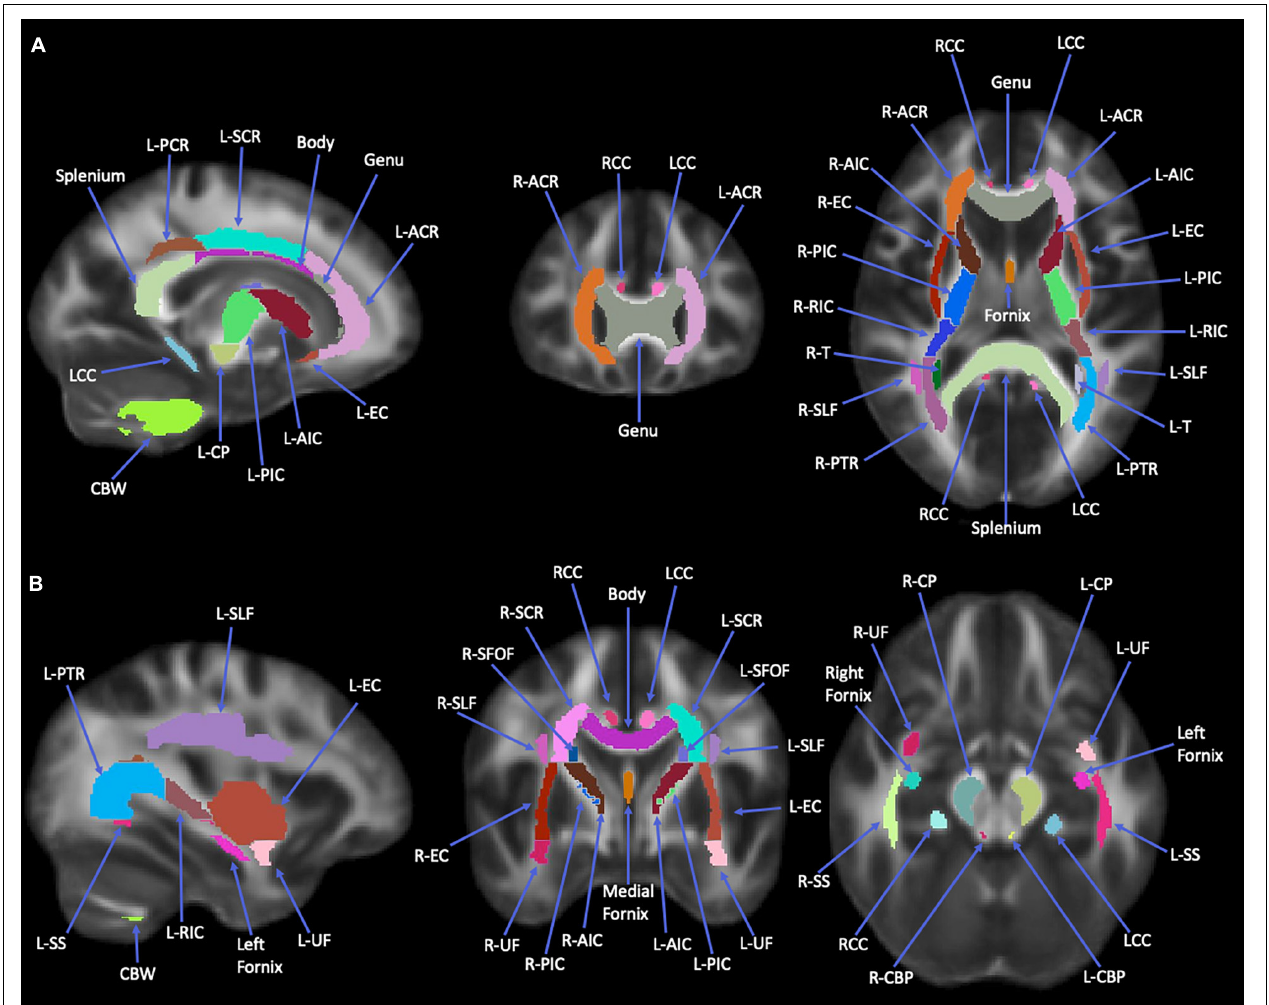
FIGURE 1 | Images of Johns Hopkins University (JHU)-ICBM-DTI-81 white matter (WM) atlas. This atlas was used to obtain the 12 regions of interest used in study analyses. Images are all WM tracts available in this atlas. (A) Orientations from left to right: sagittal, coronal, axial. (B) Orientations from left to right: sagittal, coronal, axial. Splenium, splenium of corpus callosum; Body, body of corpus callosum; Genu, genu of corpus callosum; L-ACR, left anterior corona radiata; R-ACR, right anterior corona radiata; L-SCR, left superior corona radiata; L-PCR, left posterior corona radiata; RCC, right cingulum cortex; LCC, left cingulum cortex; L-EC, left external capsule; L-AIC, left anterior limb of internal capsule; R-AIC, right anterior limb of internal capsule; L-PIC, left posterior limb of internal capsule; R-PIC, right posterior limb of internal capsule; L-RIC, left retrolenticular part of internal capsule; R-RIC, right retrolenticular part of internal capsule; L-CP, left cerebral peduncle; L-PTR, left posterior thalamic radiation; R-PTR, right posterior thalamic radiation; L-T, left tapetum; R-T, right tapetum; CBW, cerebellar white matter; L-UF, left uncinate fasciculus; R-UF, right uncinate fasciculus; R-EC, right external capsule; L-SLF, left superior longitudinal fasciculus; L-SS, left sagittal stratum; R-SS, right sagittal stratum; R-SCR, right superior corona radiata; L-SFOF, left superior fronto-occipital fasciculus; R-SFOF, right superior fronto-occipital fasciculus; R-CP, right cerebral peduncle; L-CBP, left cerebellar peduncle; R-CBP, right cerebellar peduncle. The regional masks were filtered with the white matter skeleton mask from TBSS (see Figure 2